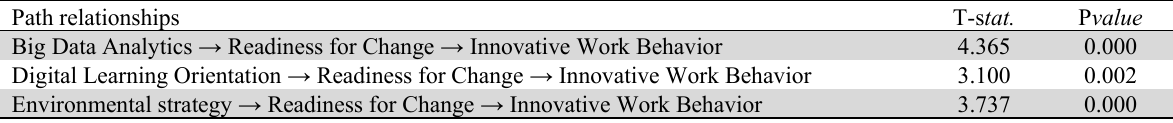
Specific Indirect Effect